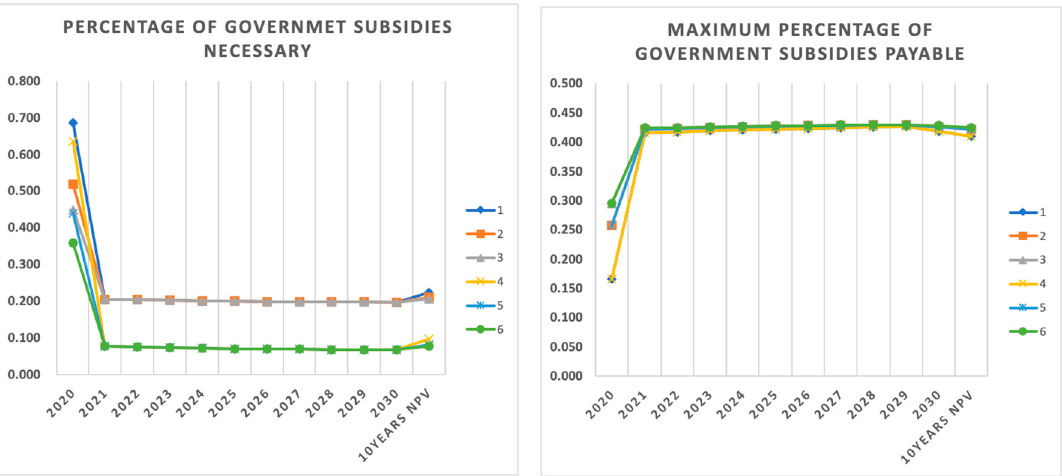
Figure 5. The range of government subsidies.